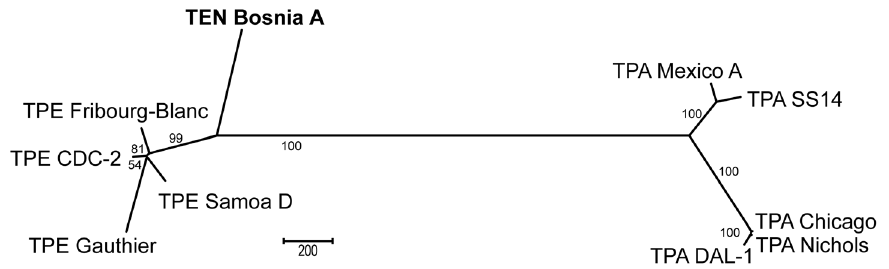
Figure 1. Unrooted tree based on the alignment of the Bosnia A genome with additional treponemal genomes. An unrooted tree was constructed from the complete genome sequences of TPA strains (Nichols, Chicago, DAL-1, SS14, and Mexico A), TPE strains (CDC-2, Gauthier, Samoa D, and Fribourg-Blanc), and the TEN strain (Bosnia A) using the Maximum Parsimony method and MEGA5 software [25]. The bar scale corresponds to a difference of 200 nucleotides. Bootstrap values based on 1,000 replications are shown next to the branches. All positions containing indels in at least one genome sequence were omitted from the analysis. There were a total of 1,128,391 nucleotide positions aligned in the final dataset.